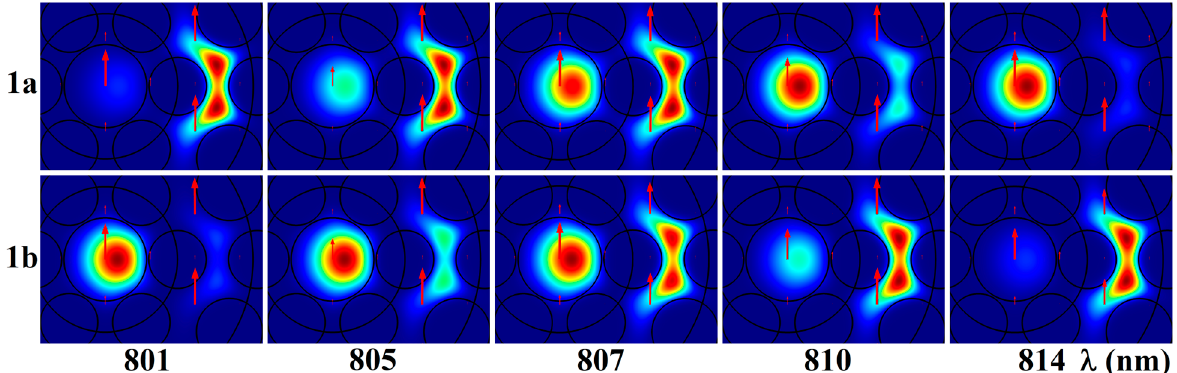
Figure 8. Spatial intensity distributions of Modes 1a and 1b in the bent MOF-18 for a bending radius of R x = 0.08 m for wavelengths of 801 nm, 805 nm, 807 nm, 810 nm, and 814 nm.